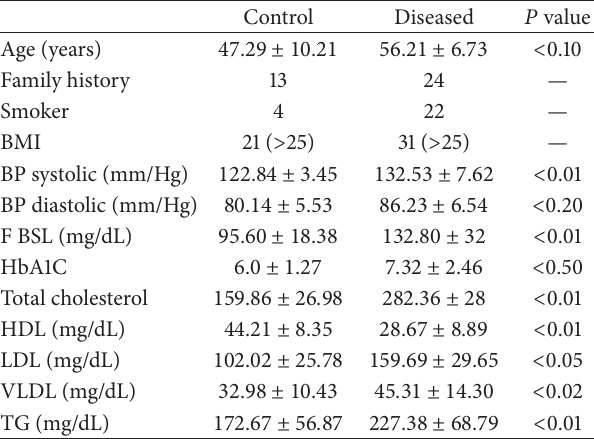
Table 1: Baseline characteristics of the study population.